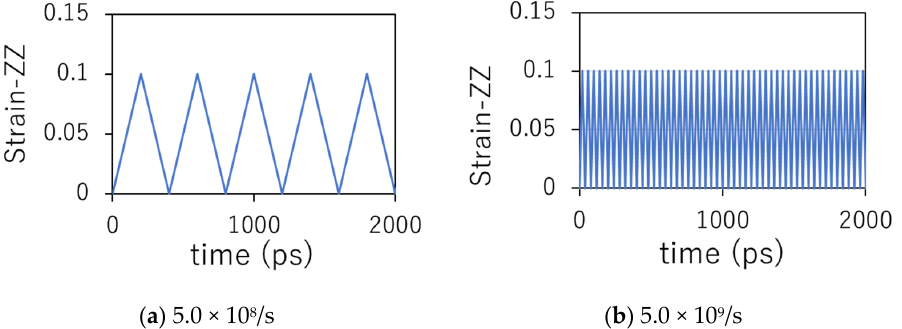
Figure 4. Relationship between time and strain in z-direction during each cyclic loading.